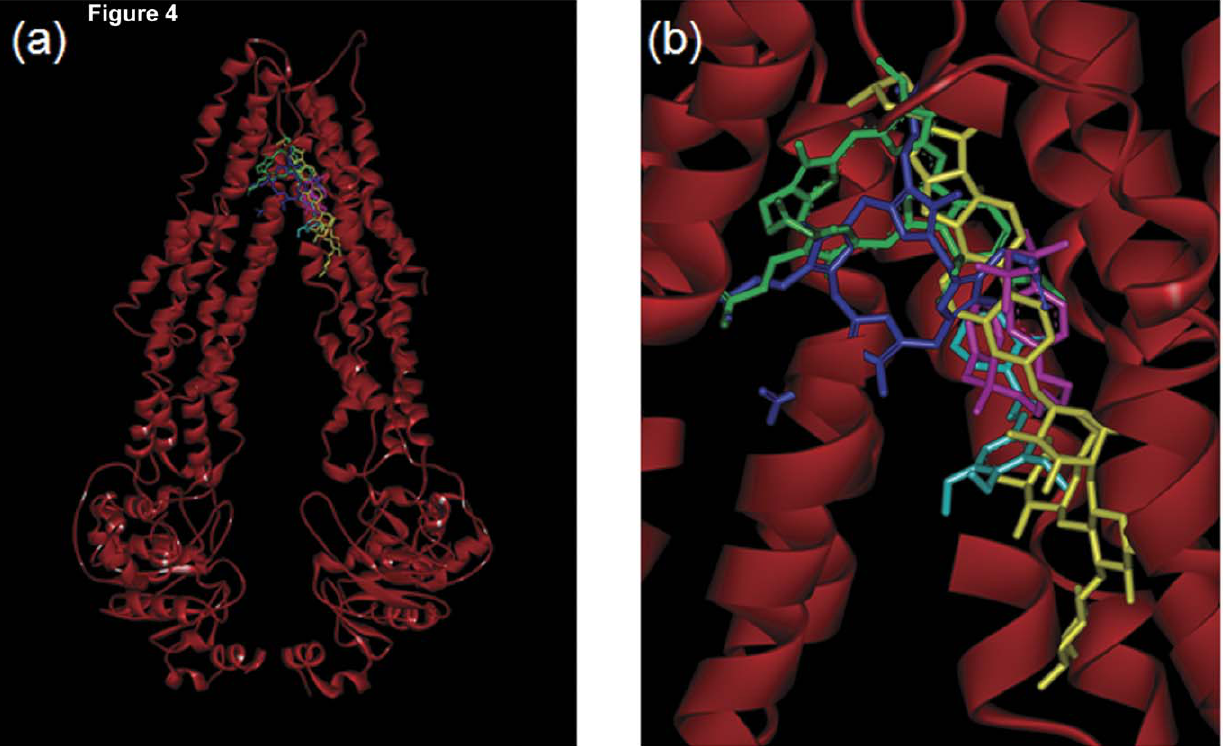
Figure 4. Topology and homology model of ABCB6 dimer with the docked ligands. (a) far and (b) close view of docking poses of selected ligands to the human ABCB6 transporter. Coproporphyrinogen III – blue; verteporfin – green; benzethonium chloride– magenta; piperlongumine - light blue; and tomatine hydrochloride - yellow. The Gly426-Val429, and Phe545-Pro555 parts from one ABCB6 monomer were hidden in order to better see the